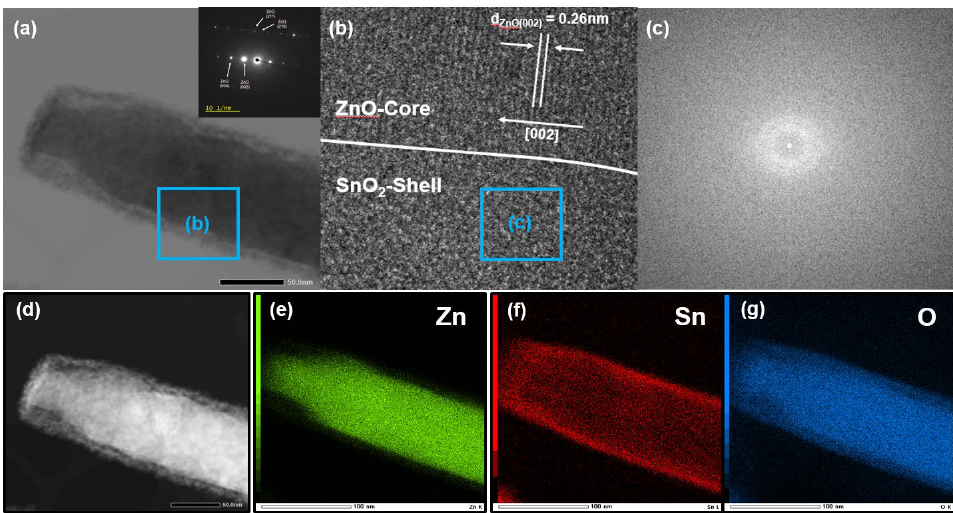
Figure 3. TEM images of ZnO/SnO 2 NR. ( a – b ) TEM image of ZnO/SnO 2 NR and magnified view of the boundary region between the ZnO core and the SnO 2 shell. ( c ) The corresponding FFT image of the SnO 2 shell region and ( d – g ) STEM image of ZnO/SnO 2 NR and corresponding elemental maps of Zn, Sn, and O, respectively.